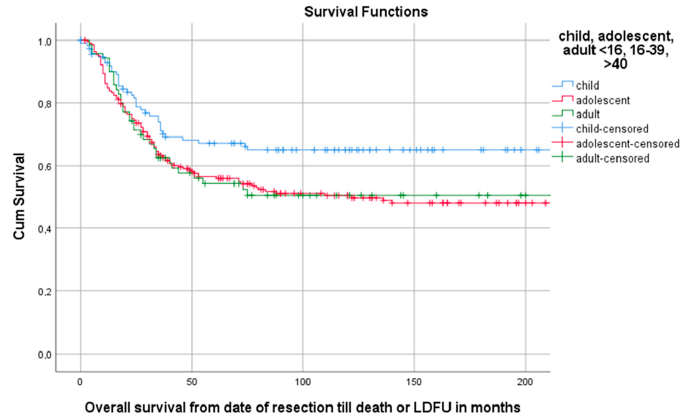
Figure 2. Kaplan–Meier (KM) estimation of OS in the total cohort divided by age group. Legend: OS = overall survival, cum survival = cumulative survival, LDFU = last date of follow-up.